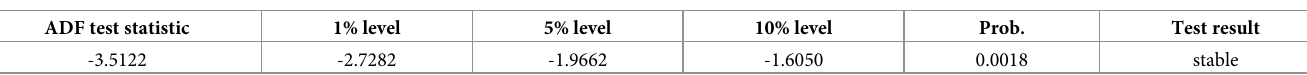
Table 7. ADF test results for internal R&D